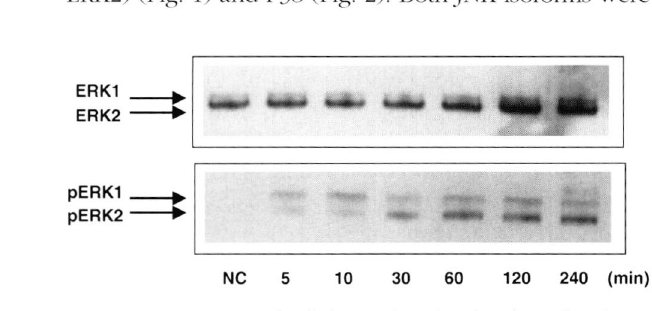
weakly activated with a maximum at 10 minutes (JNK1) and a decrease toward basal level after 60 minutes (Fig. 3). These results show that invasion by